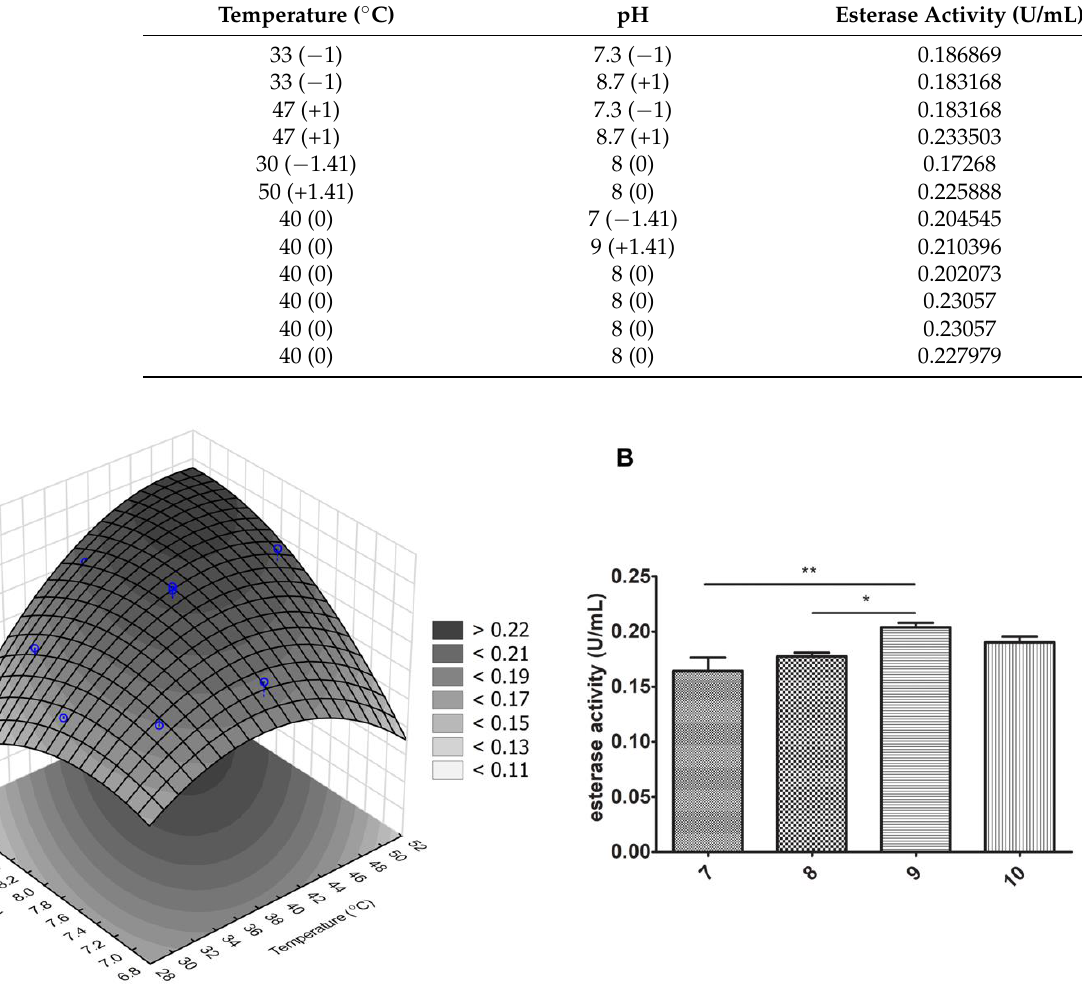
Figure 6. Temperature and pH effects in esterase activity of J. curcas esterase B. ( A ) Assessment of their effects were done with a central composite rotational design. Higher esterase activity was observed with higher temperatures and pH values, as observed in ( B ). * p < 0.05 and ** p < 0.01.